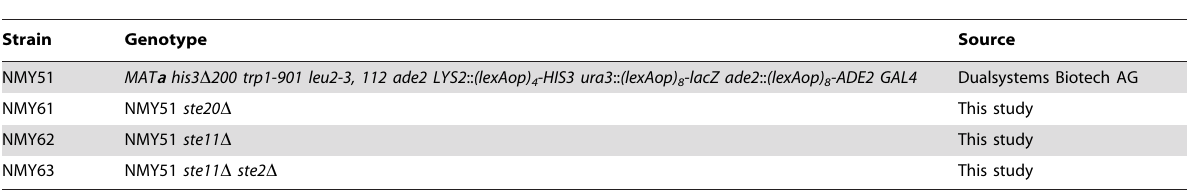
Table 1. Yeast strains used in this study.